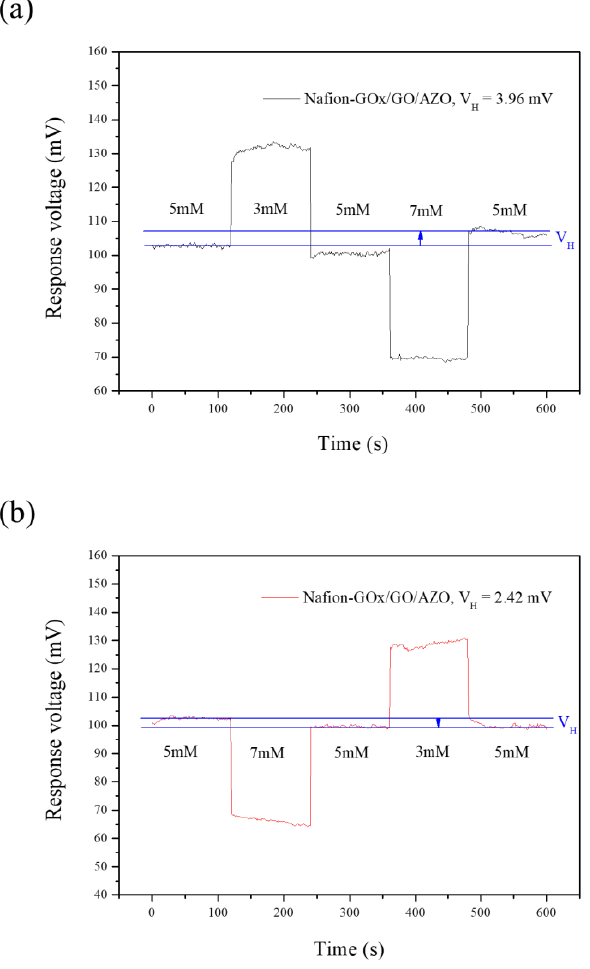
Figure 10. Hysteresis curves of the potentiometric arrayed glucose biosensor based on Nafion- GOx/GO/AZO across multiple cycles of ( a ) 5 mM → 3 mM → 5 mM → 7 mM → 5 mM and ( b ) in the mM → 7 mM → 5 mM → 3 mM → 5 mM, cycle of 5 mM → 7 mM → 5 mM → 3 mM → 5 mM, respectively.